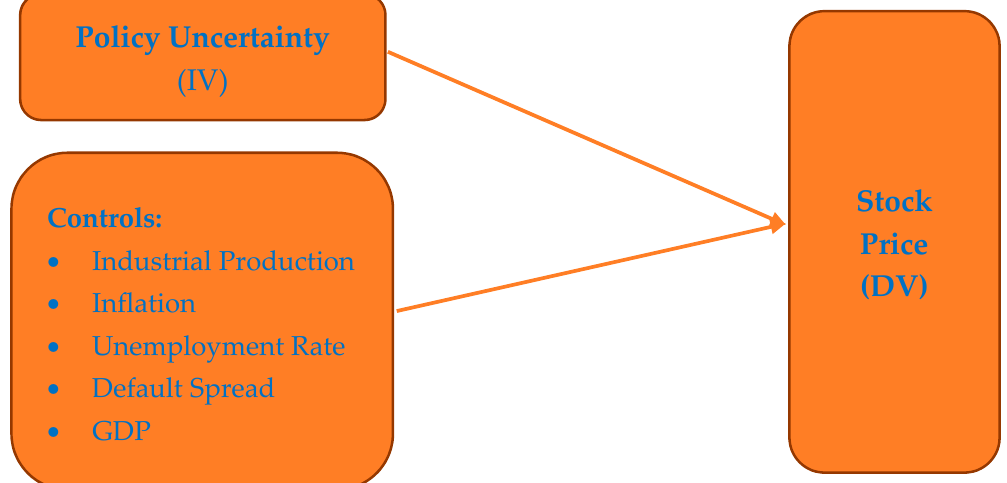
Figure 1. Theoretical framework, IV: independent variable (measured by news-based policy uncertainty—PU_NB) and DV: dependent variable. Source: Drawn from the literature (Arouri et al., [14], and Bahmani-Oskooee and Saha, [15]).